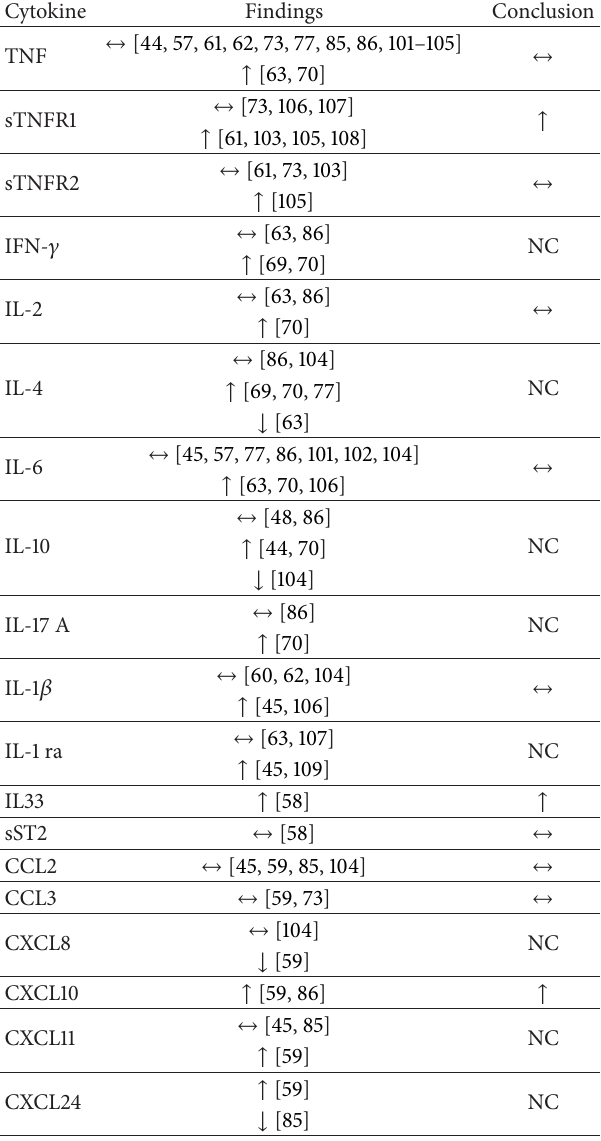
Table 1: Cytokine peripheral levels in bipolar disorder patients in euthymia compared with